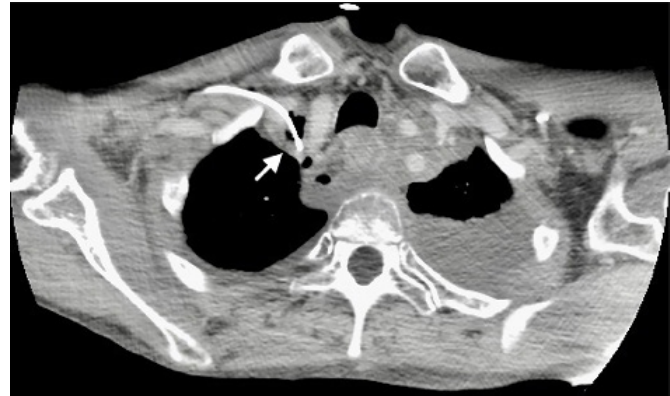
Image 3. Transverse computed tomography thorax identifying peripherally inserted central catheter line perforation of right innominate vein, located superiorly and extraluminal in right upper mediastinum (arrow) with a large left pleural effusion.